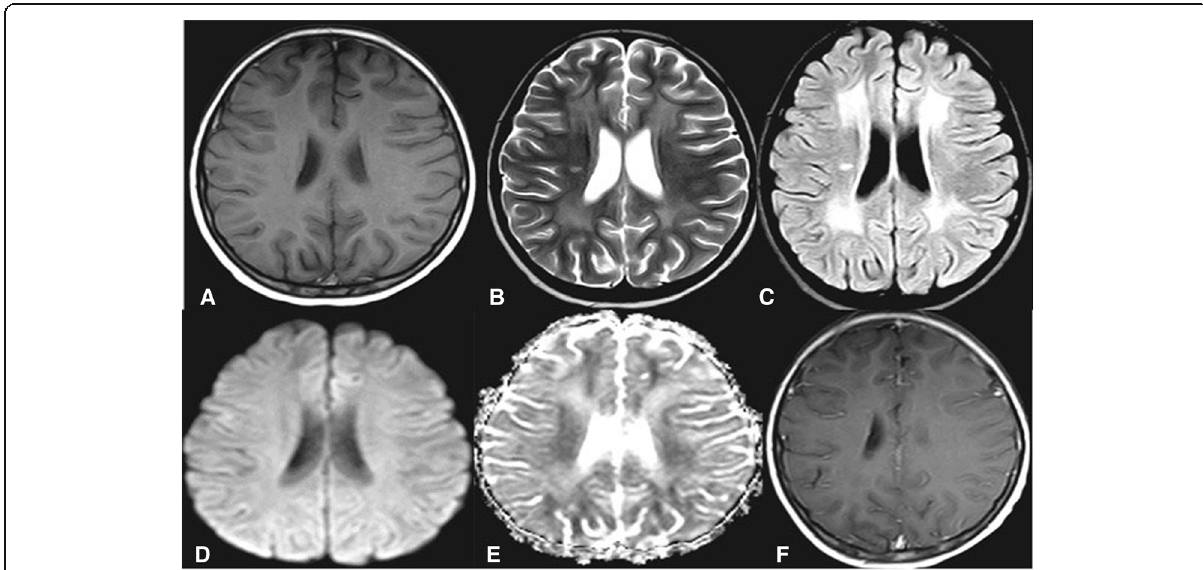
Fig. 5 MRI examination of an 11-year-old post-allogenic HSCT patient presenting with headache. a , b , c Conventional non-enhanced T1 axial ( a ), T2 axial ( b ), and FLAIR axial (C) images revealing bilateral rather symmetrical periventricular and centrum semiovale high T2/FLAIR signal appears isointense at T1 images. e , f Bilateral periventricular high signal in DWI b = 1000 ( e ) with similar high signal at the ADC map ( f ). d Contrast- enhanced axial image: no evident post-contrast enhancement. Radiological pattern impressive of